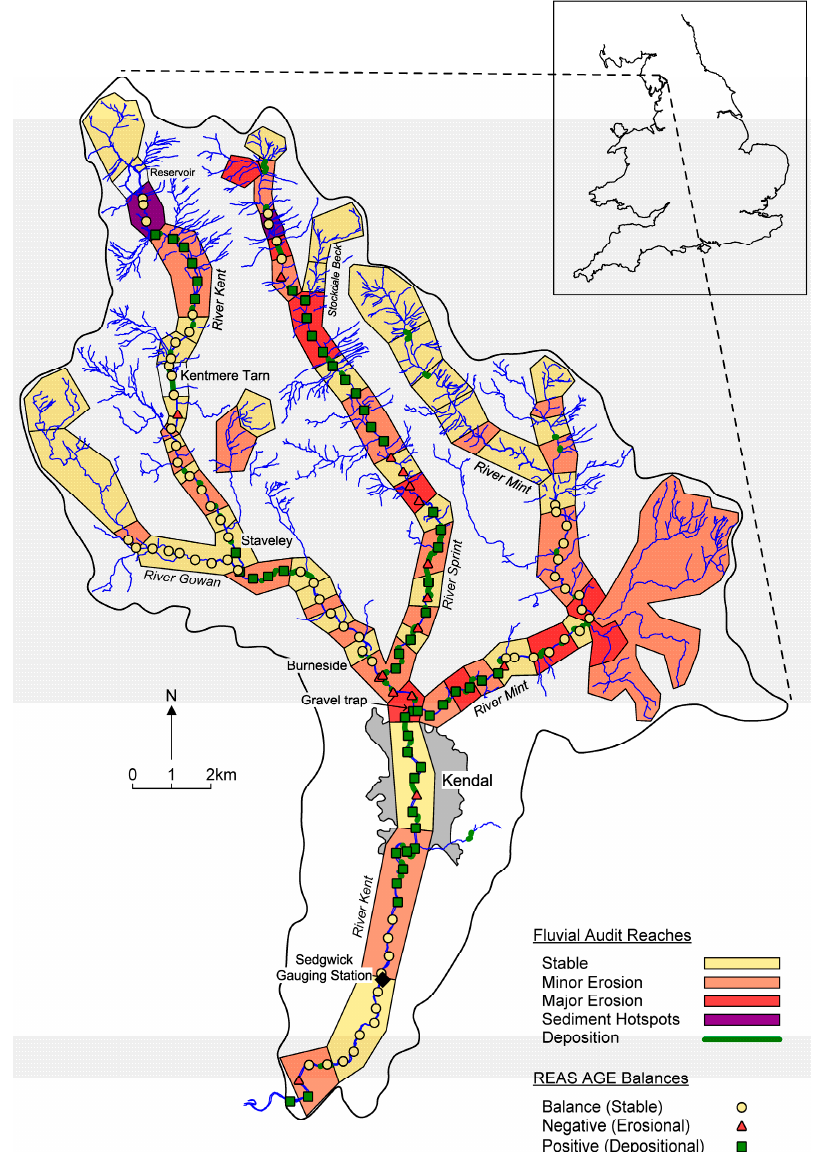
Figure 1. Comparison between REAS (River Energy Audit Scheme) and Fluvial Audit reaches within the River Kent drainage basin, Cumbria, UK. REAS reaches are expressed as balances (differentials) in Annual Geomorphic Energy (AGE) for contiguous reaches and Fluvial Audit reaches are characterised after Orr et al. [188]. Inset: Location of the drainage basin in north ‐ west England. In the Fluvial Audit, no reaches were classified as entirely depositional but zones of deposition were mapped within broadly stable or erosional reaches.